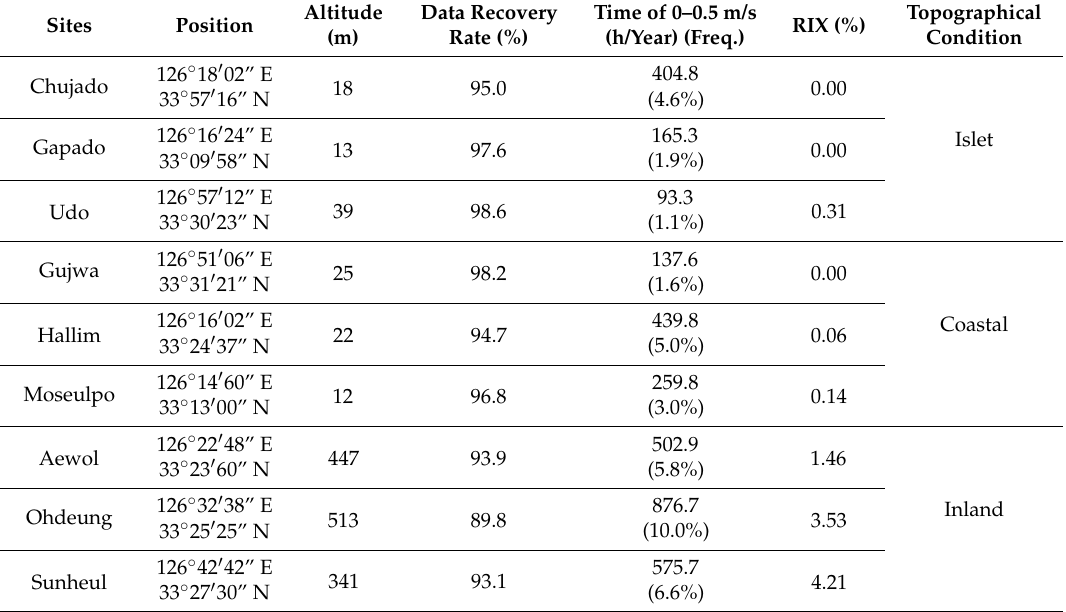
Table 1. Sites and measurement conditions. Freq.: Frequency.